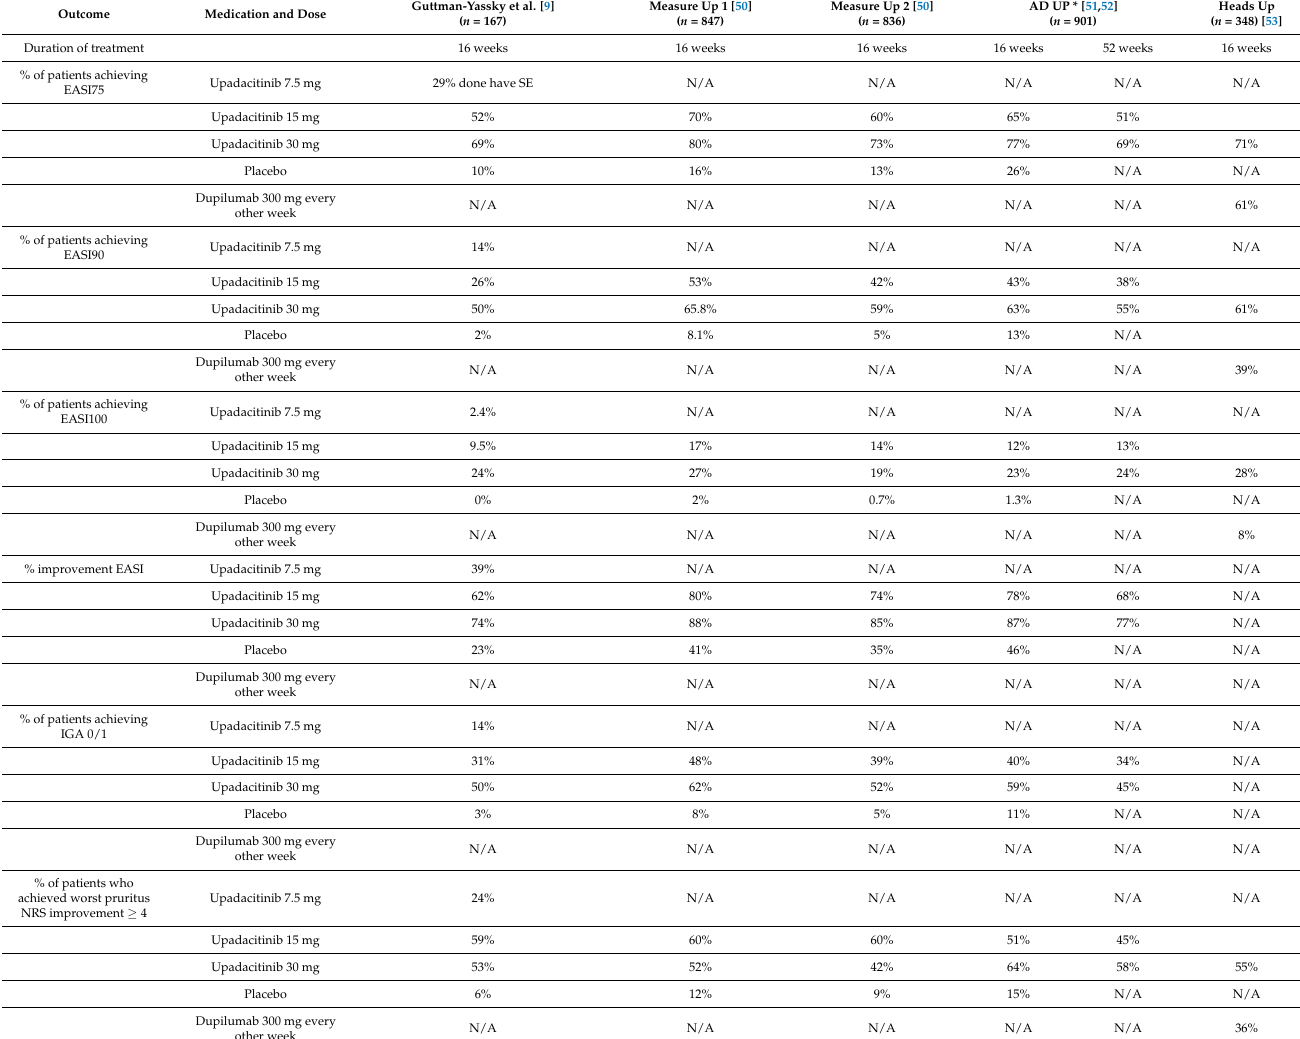
Table 1. Summary of efficacy outcomes for clinical trials completed with upadacitinib treatment in patients with moderate-to-severe atopic